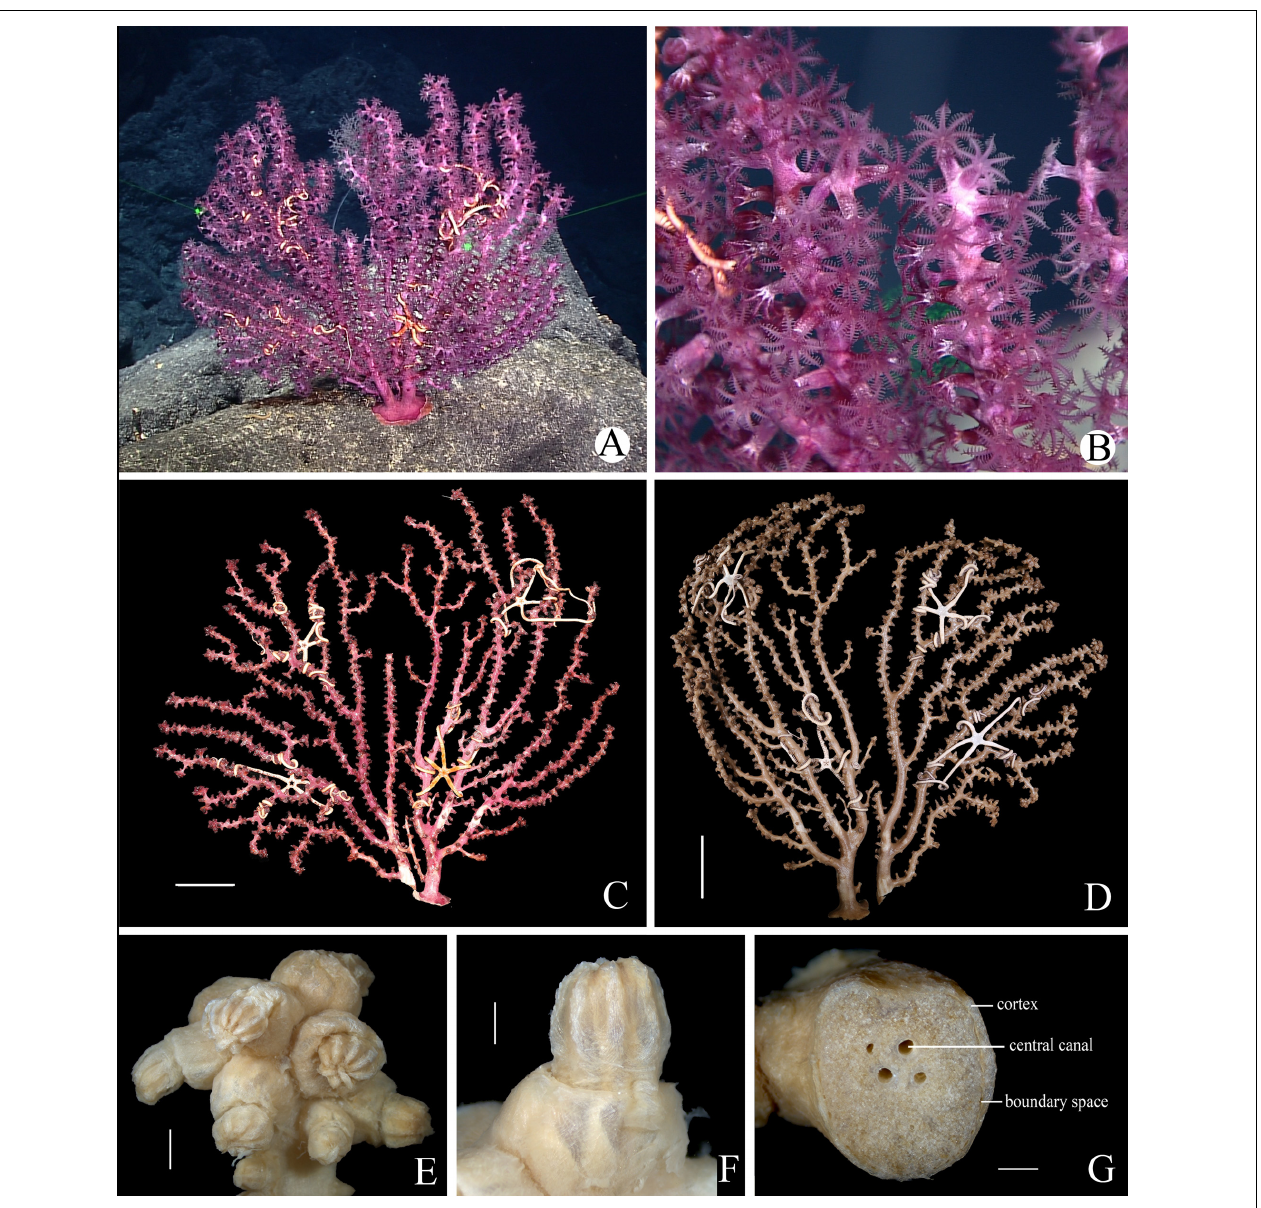
FIGURE 5 | Morphology of Victorgorgia iocasica sp. nov. (A) In situ . Laser dots spaced at 33 cm used for measuring dimensions. (B) Close view in situ , showing expanded polyps. (C) The side with more autozooids of freshly collected specimen, photographed by Shaoqing Wang. (D) The side with fewer autozooids